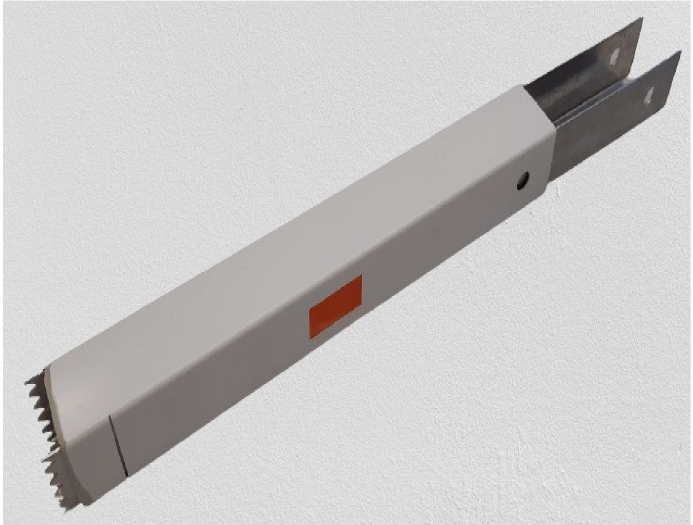
Figure 2. Snow core sampler.